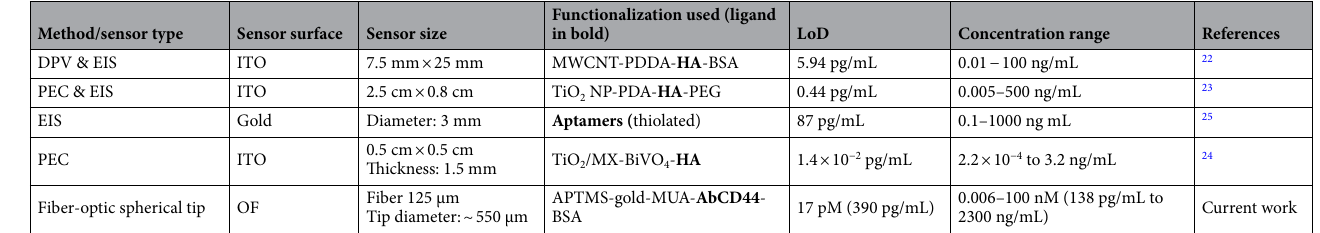
Table 1. Currently available biosensors developed for detection of CD44 protein. Listed by the date of publication (from older to more recent). AbCD44 antibodies against CD44 protein, APTMS (3-aminopropyl) triethoxysilane, DPV differential pulse voltammetry, EIS electrochemical impedance spectroscopy, HA hyaluronic acid, ITO indium tin oxide, MUA mercaptoundecanoic acid, MWCNT multiwalled carbon nanotubes, NP nanoparticles, OF optical fiber, PDA polydopamine, PDDA poly(diallyldimethylammonium chloride, PEC